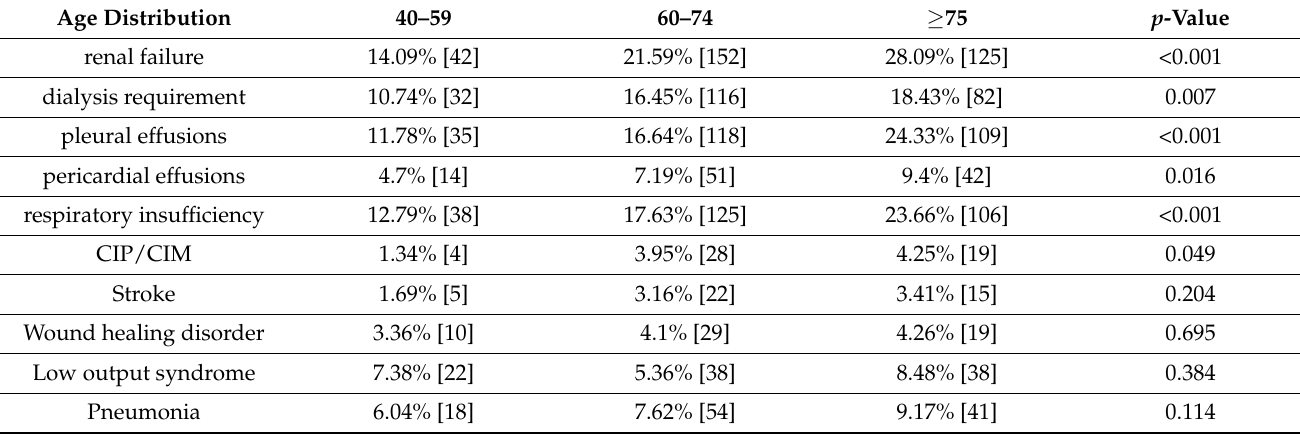
Table 2. Postoperative